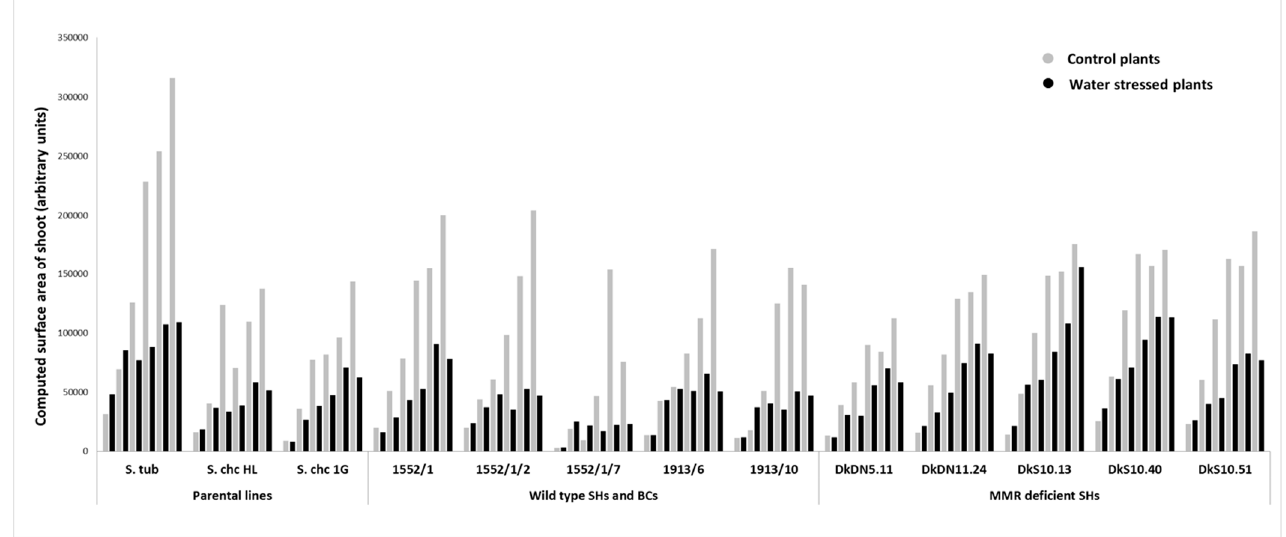
Figure 8. Biomass accumulation changes of the analyzed Solanum genotypes during the six-week drought stress, as tracked on the phenotyping platform. The biomass accumulation of plants was recorded once per week as detailed in Section 2.